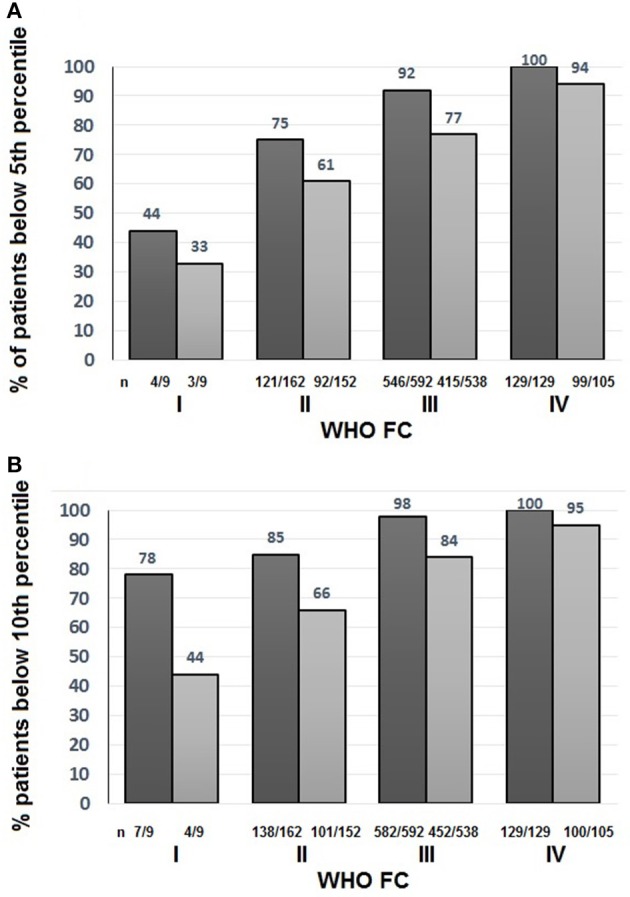
Percentage of all patients with Incremental shuttle walk distance percent predicted (ISWD%pred)  and Diffusing capacity across the lung for carbon monoxide percent predicted (DLco%pred)  less than (A) the 5th percentile and (B) the 10th percentile World Health Organization Functional Class (WHO FC).